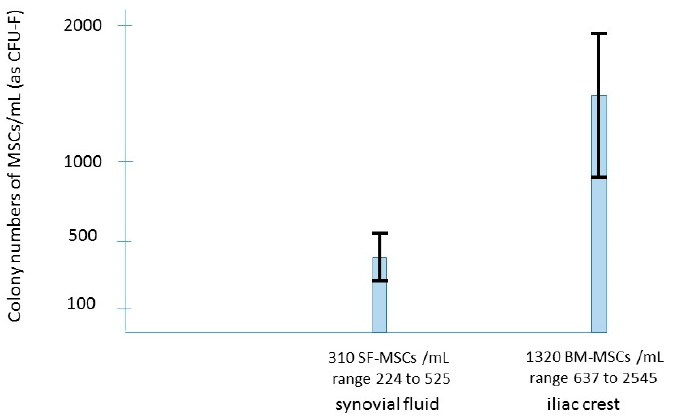
Figure 1. Comparison among synovial fluid MSCs and bone marrow iliac crest MSCs from osteoarthritis patients.